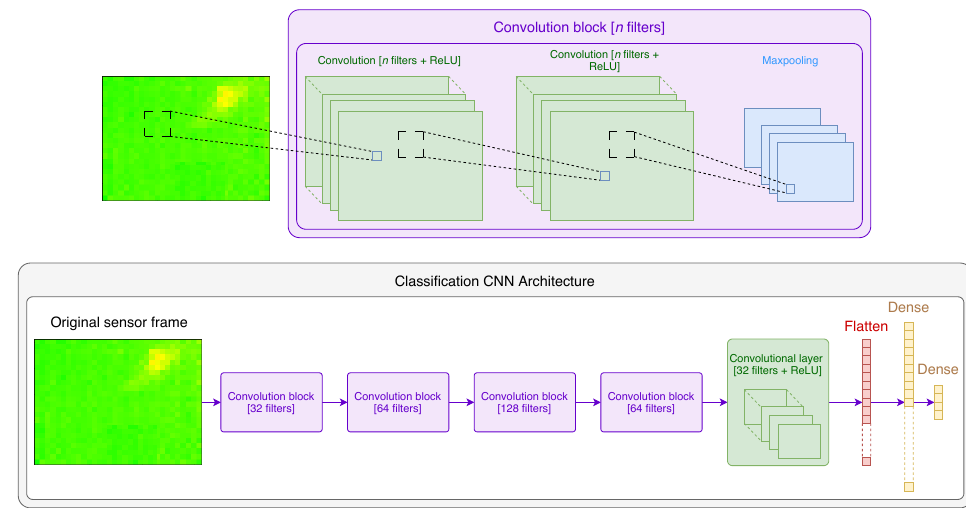
Figure 8. The architecture of the neural network used for